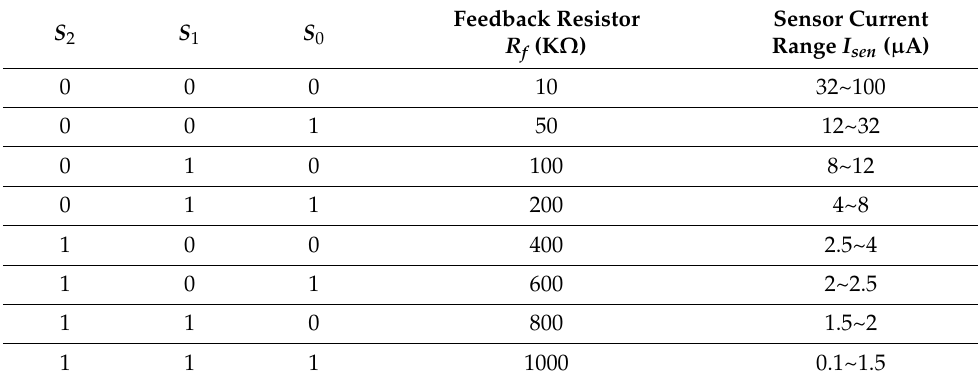
Figure 5. Block diagram of the feedback stage. Table 1. Feedback resistor selection with sensor current range.